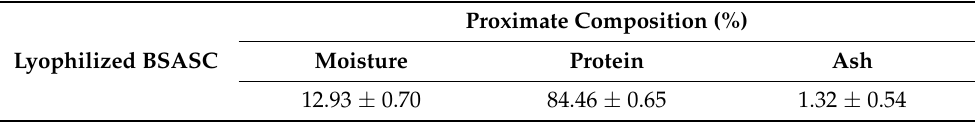
Table 1. The proximate composition of lyophilized BSASC extracted from the skin.